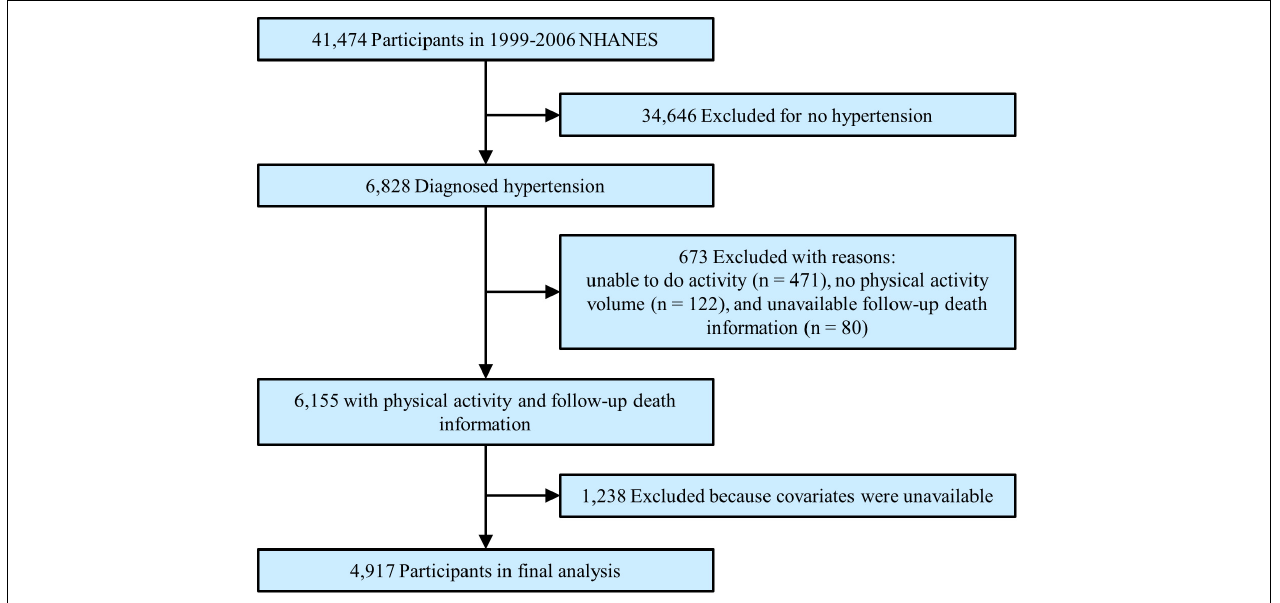
FIGURE 1 | Study flowchart. Flowchart showing the process of participant selection. Of 41,474 participants from 1999 to 2006 National Health and Nutrition Examination Survey (NHANES), 4,917 remained in the final analysis.